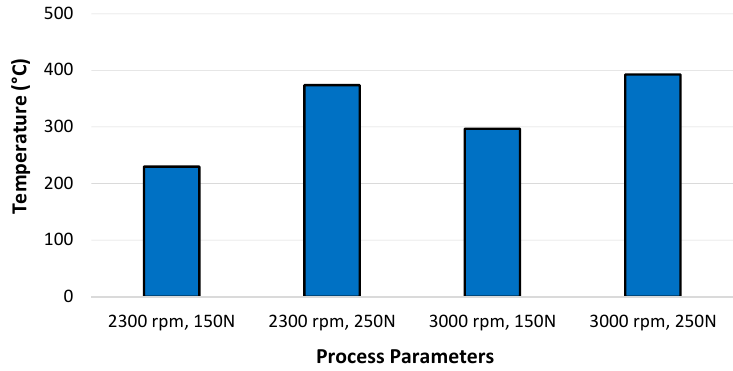
Figure 7. Maximum temperature in the friction surfacing process.